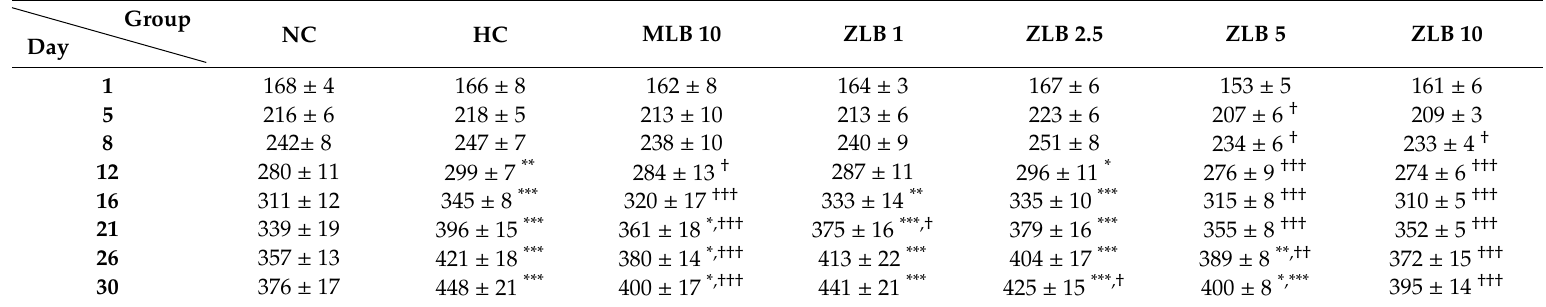
Table 1. E ff ects of MLB and ZLB on weight gain (g) in rats fed a normal diet or a high-fat diet for 4 weeks.